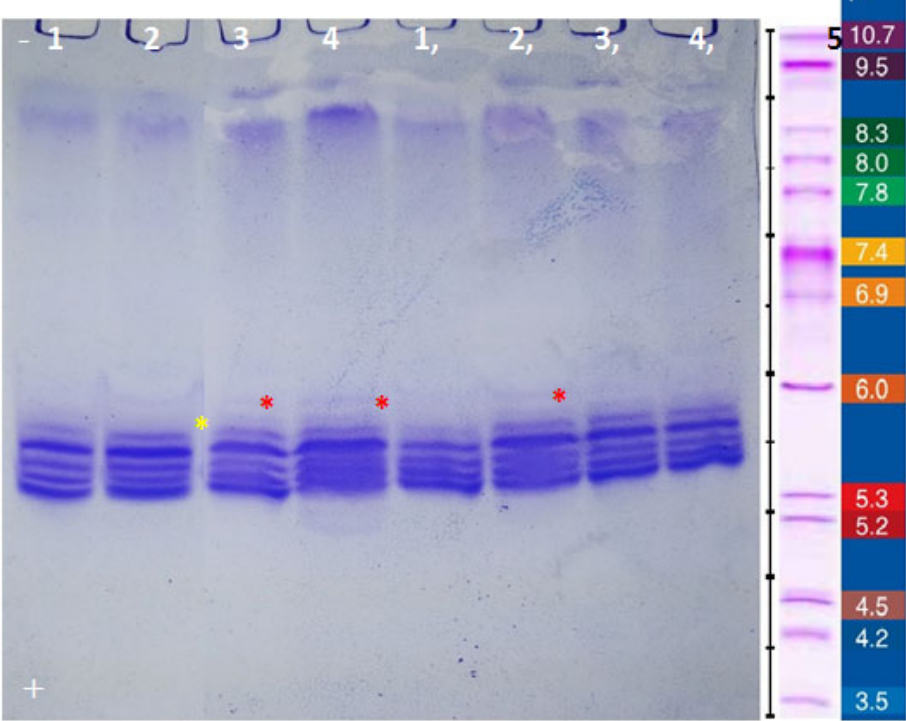
Figure 3. Profiling of casein purified from camel milk according to its isoelectric focusing (IEF) in slab gel of pH range 3–10. Lane 5 and the right bar represent Serva IEF marker, lanes 1–4 show casein from the milk of Saudi camel clans Majahem, Wadha, Hamra, and Safra, lanes 1 ′ –4 ′ , same camel clans sequences but with new individual milk, respectively. Plus and minus signs indicate the anode and cathode electrodes, while red and yellow asterisks indicate the existence (a faint band) and mission IEF band, respectively.